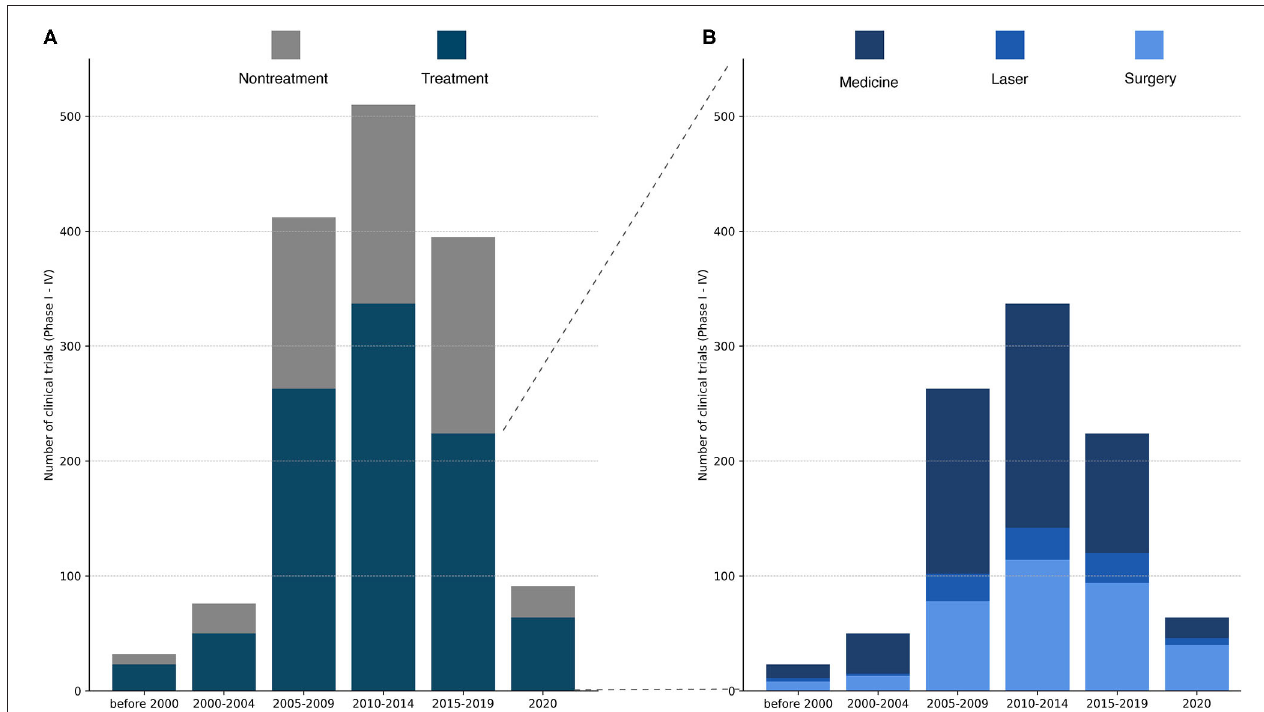
FIGURE 1 | (A) Total number of registered glaucoma clinical trials (Phase I–IV) over time. Each study was categorized as treatment or non-treatment. The number of clinical trials increased dramatically from 2000–2004 to 2005–2009, peaking in 2010–2014 and declining in 2025–2019. Of important note, the last column contains only trials from 2020, while the other columns cover a period of at least 4 years. (B) Total number of registered clinical trials in the treatment group divided into medical treatment, laser treatment or surgical treatment. Medical treatments constitute the majority of the assessed glaucoma treatments except from 2020, where surgery was the most frequently evaluated treatment in glaucoma trials.